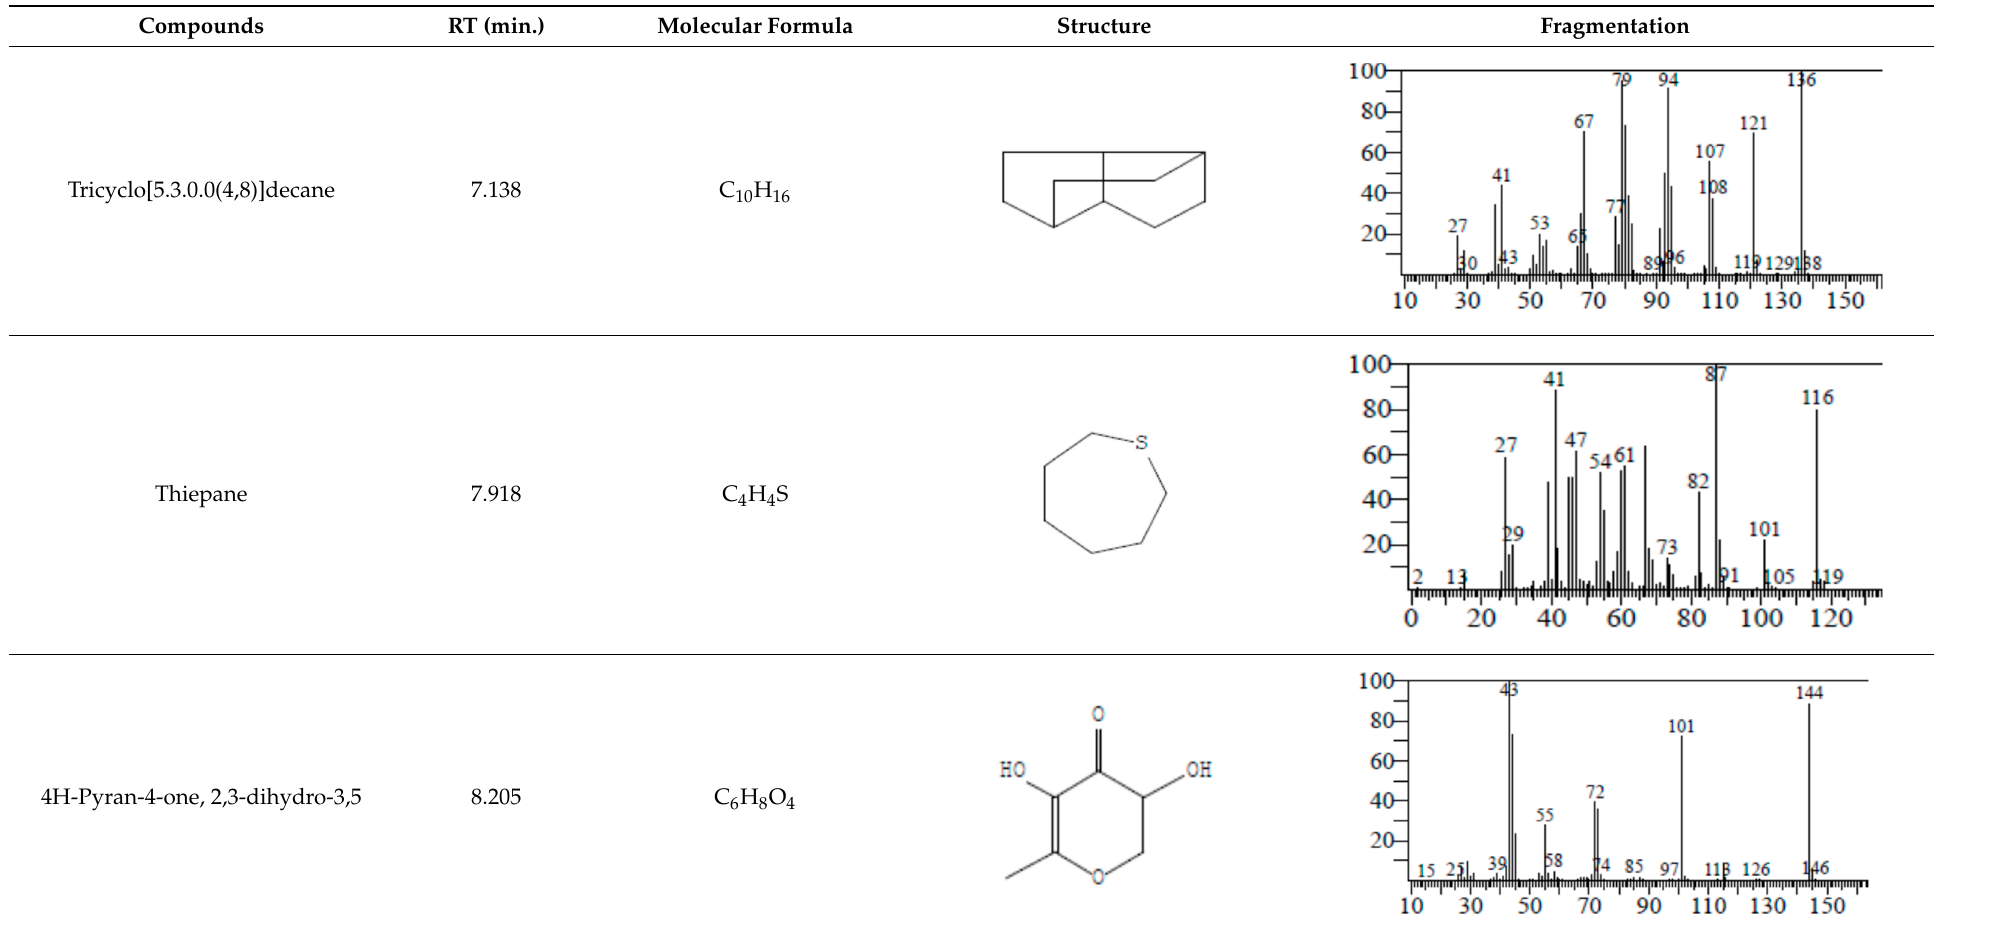
Table 2. GC–MS analysis of E. sativa leaf extract.